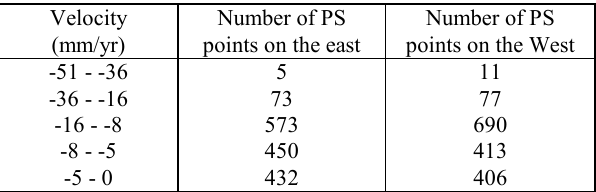
Table.1 Statistics of PS points